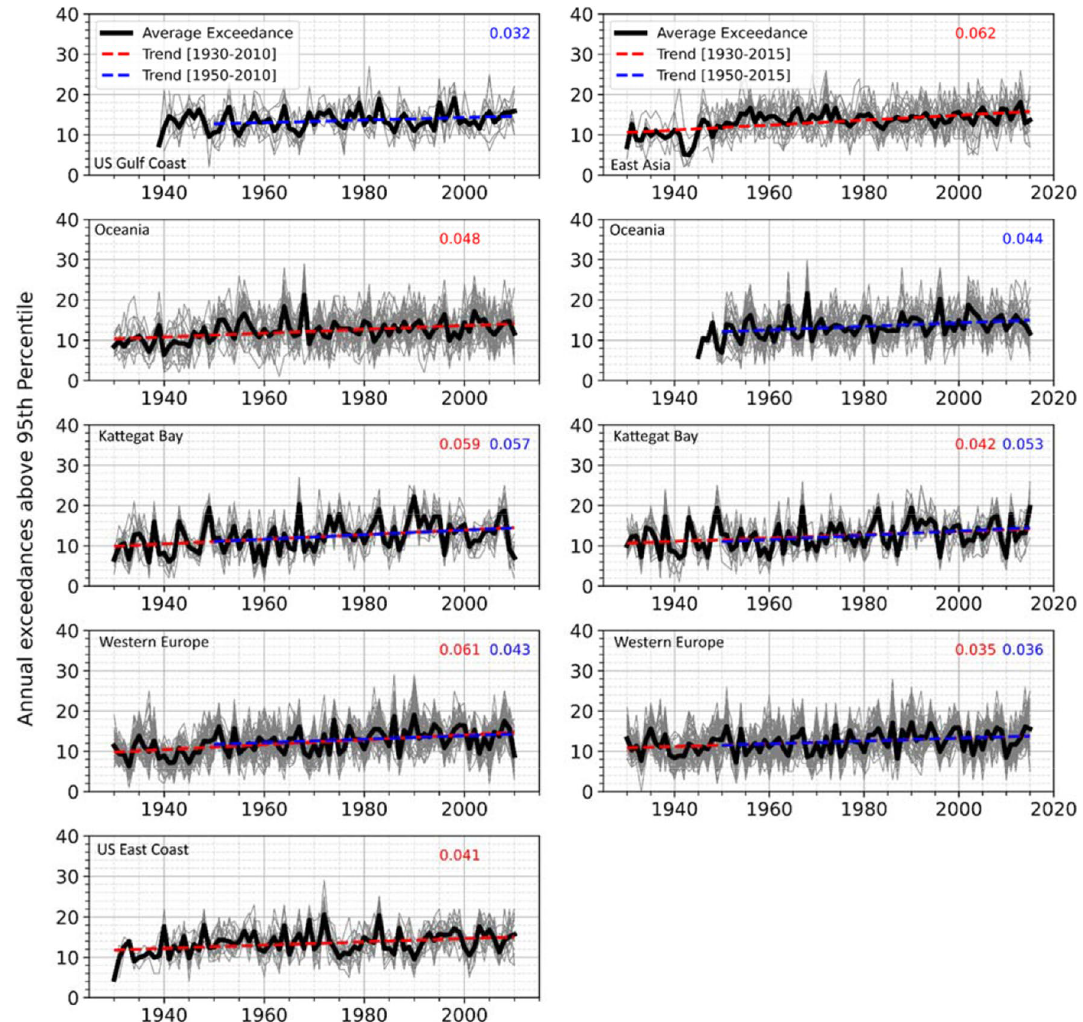
Figure 11. Regional storm frequency trends. Linear trends are fitted to the average number of annual exceedances above the 95th percentile (bold black line) for G-E20C reconstructions (left) and G-20CR reconstructions (right). Gray lines indicate the number of surge events exceeding the 95th percentile threshold for individual tide gauges in the given region. Only regions with at least one significant trend (dashed lines) are